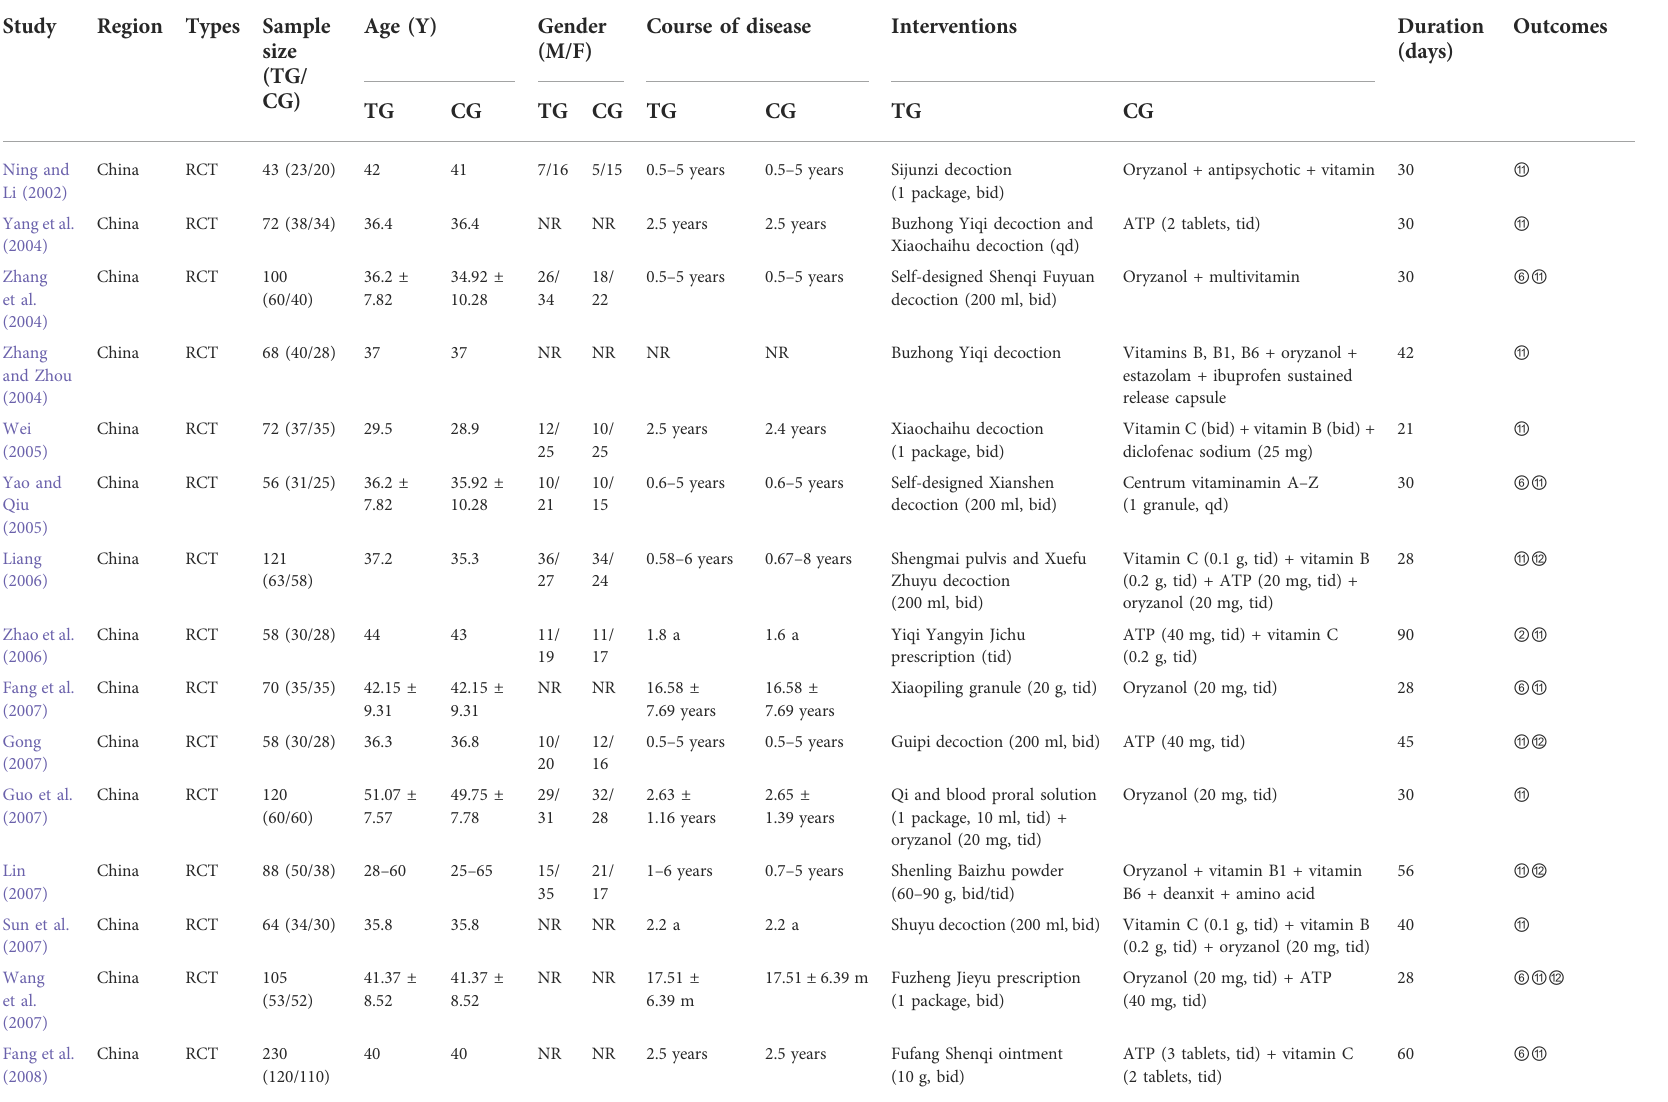
TABLE 1 Characteristics of the included